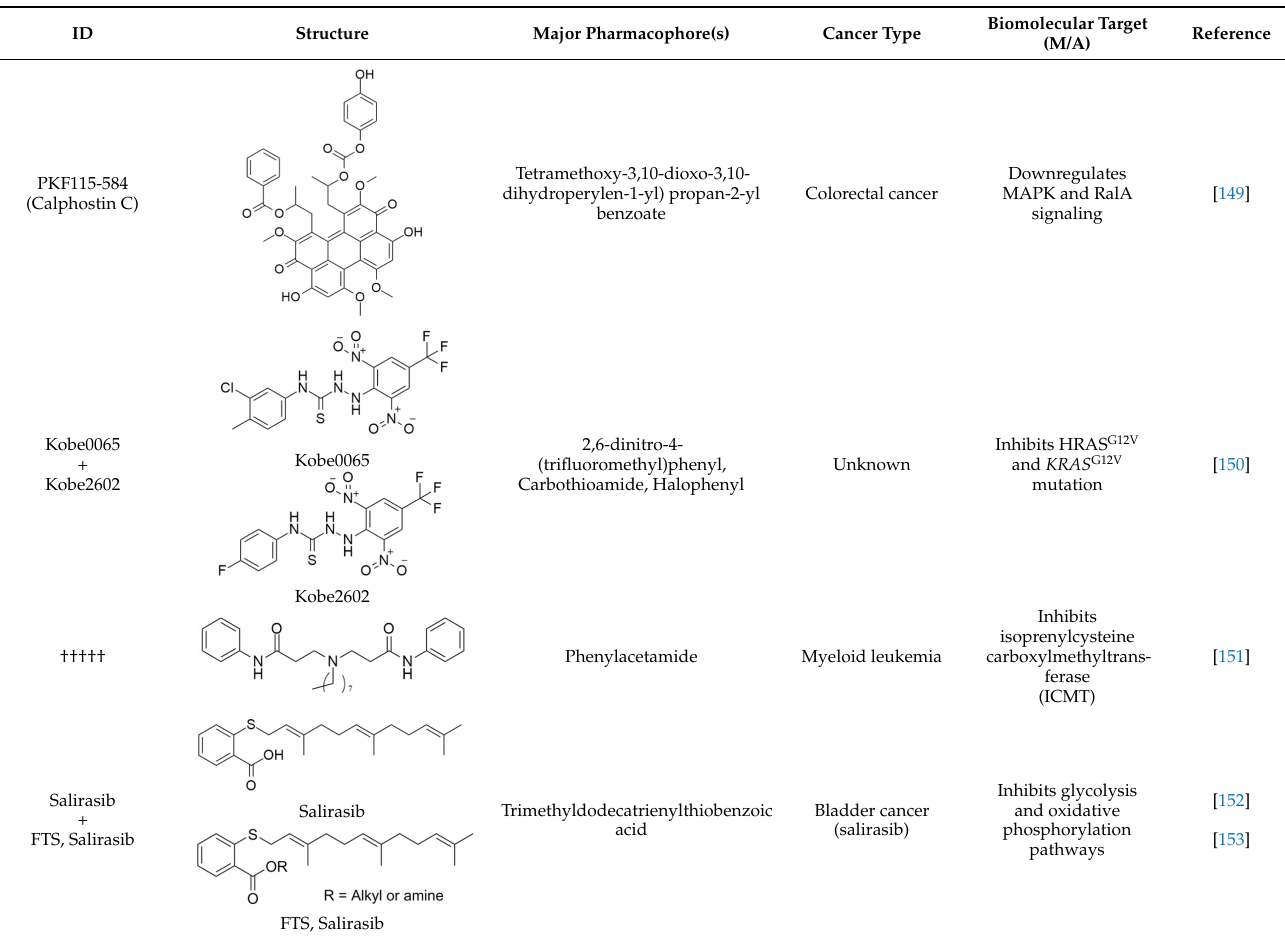
Table 5. Carbocyclic small-molecule RAS